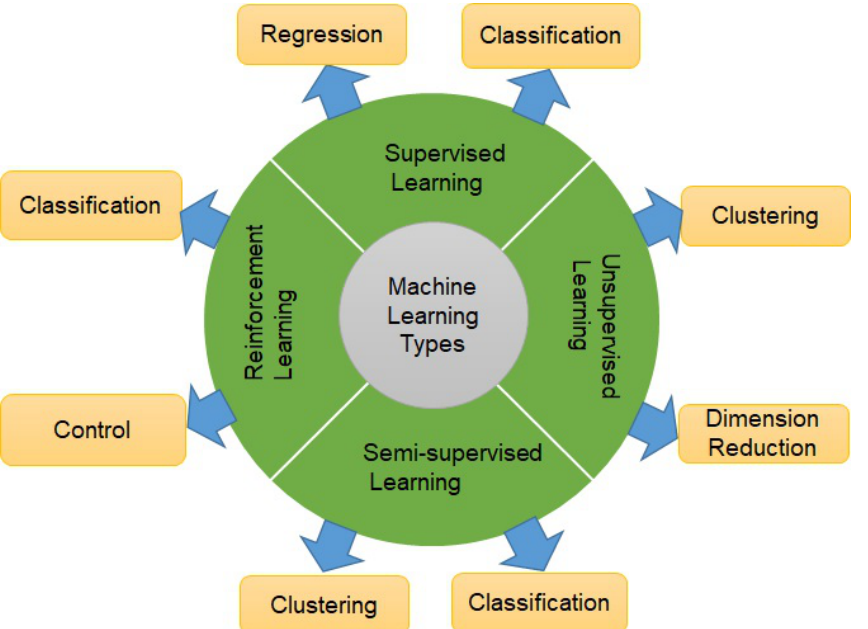
Figure 1. Overview of machine learning